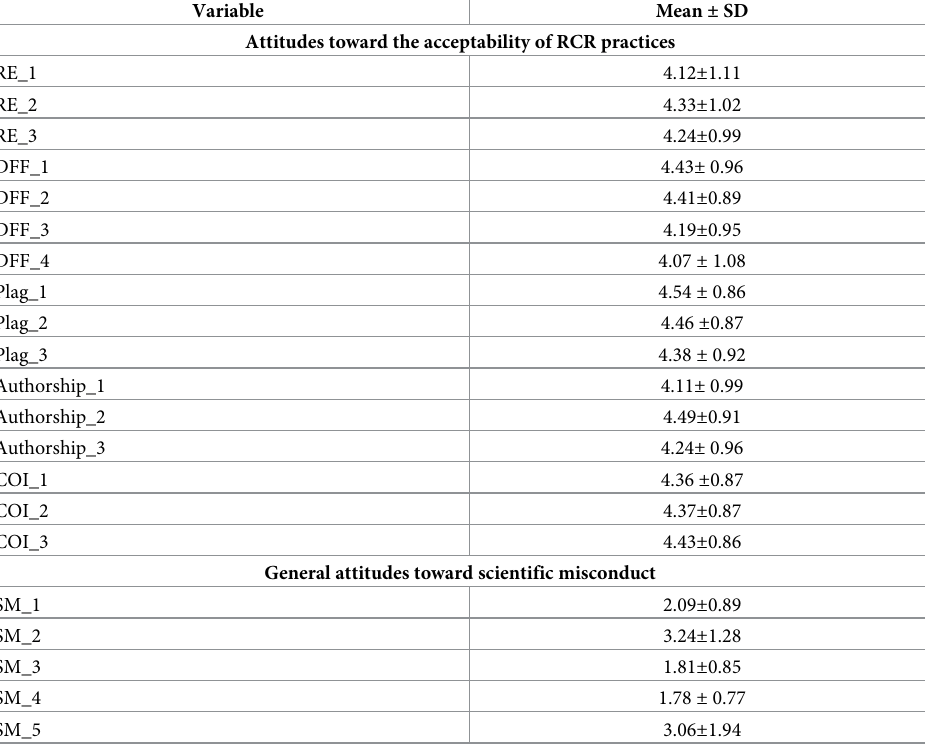
Table 4. Descriptive statistics (mean ± SD) of the different items of the attitude